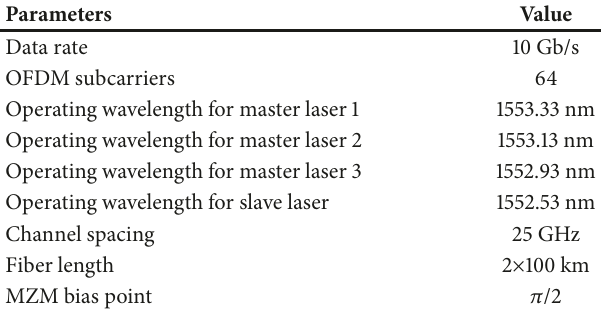
Table 1: Different parameters of 3-channel OFDM-WDM